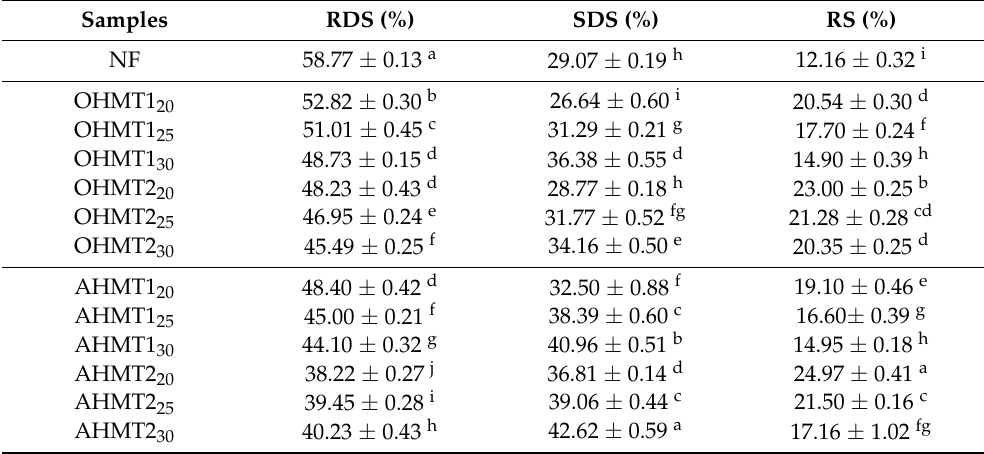
Table 2. RDS, SDS, and RS contents in OHMT and AHMT purple rice flour